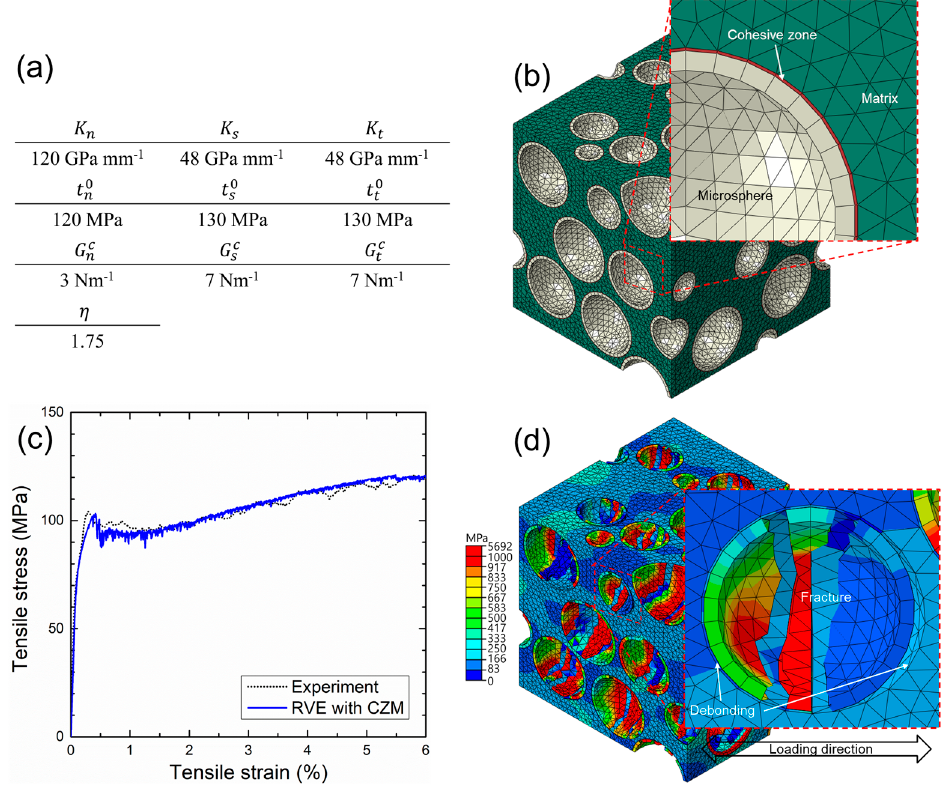
Figure 11. ( a ) Input parameters for cohesive zone model; ( b ) Geometry of representative volume element (RVE) with cohesive elements; ( c ) Stress–strain curve of numerical results compared with experiments; ( d ) Equivalent stress field near a debonded microsphere at 6% strain.